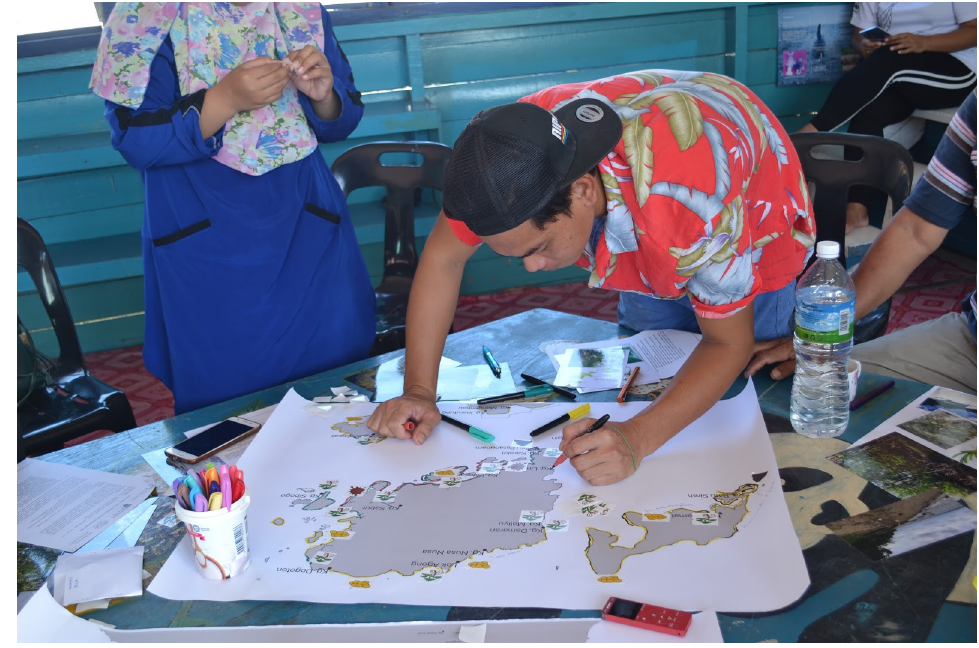
Fig 3. Participants responded to the questions in participatory